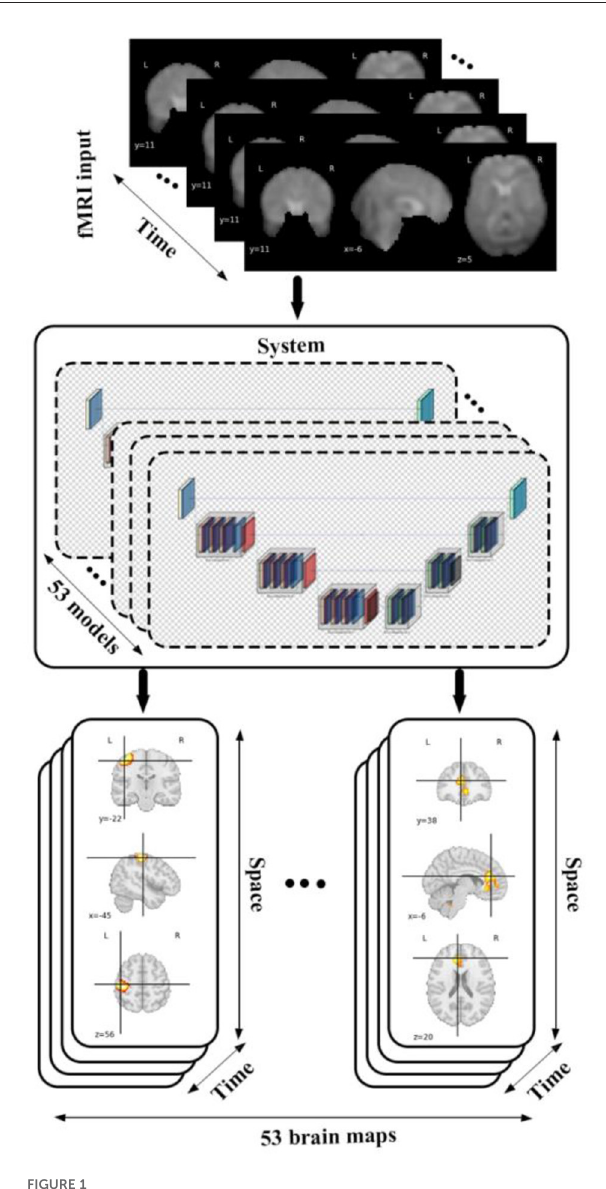
FIGURE1 The diagram shows data flow in our framework by feeding an fMRI input into 53 different models each of which belongs to a specific brain domain like visual, cerebellar, auditory, sensory motor, default mode, cognitive control, subcortical leads to generating spatiotemporal maps (4D maps) for each of brain networks.